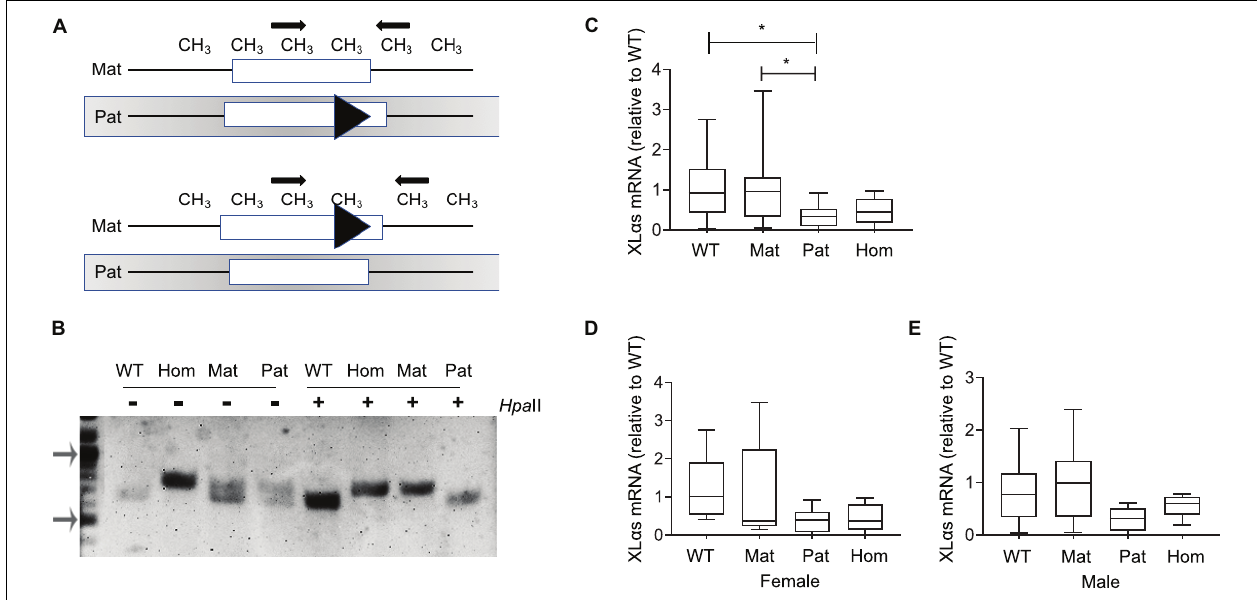
FIGURE 1 | XL α s mRNA levels in maternal and paternal XL α s knockout mice to examine the allele-specific expression of XL α s. (A) Depiction of the normal and targeted (triangle) Gnas alleles comprising the first exon of XL α s in mice in which either the paternal (above) or the maternal (below) allele is targeted. The methylation (CH 3 )-sensitive restriction enzyme Hpa II cleaves the unmethylated (paternal) allele at multiple sites. Thus, the PCR performed using the Hpa II-digested DNA detects only the intact maternal allele. (B) PCR products from WT (wildtype), homozygous (hom), maternal (mat), and paternal (pat) DNA samples obtained before ( − ) or after (+) the Hpa II restriction enzyme. Note that the targeted allele produces a larger product. PCR products from maternal and homozygous XLKO after the Hpa II digest are larger than those from paternal XLKO and WT. Arrows indicate the 1,000- and 500-bp bands in the DNA ladder. (C) Box and whisker plots showing XL α s mRNA levels in bones from 14-week-old WT, maternal XLKO, paternal XLKO, and homozygous XLKO mice. (D,E) Female and male mice plotted separately. RNA was obtained from femurs after flushing out the bone marrow. qRT-PCR was performed with β -Actin as reference. Data were normalized to wildtype. * p < 0.05; using one-way ANOVA, followed by Tukey’s post-hoc test for pairwise comparisons; n = 18 WT (8 female and 10 male), 16 maternal XLKO (5 female and 11 male), 17 paternal XLKO (6 female and 11 male), and 16 homozygous XLKO (10 female and 6 male).